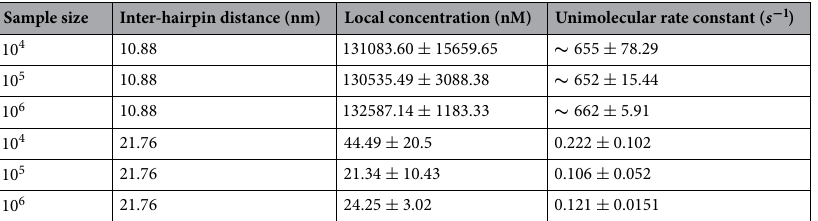
Figs. S12–S15), or 10 6 samples (Supplementary Figs. S16–S19). As expected, we observe greater similarity between the five replicate plots when the number of samples is greater; as the number of samples drops to 10 4 or even 10 3 we observe significant differences due to sampling error. Therefore, we must be careful to use a large enough